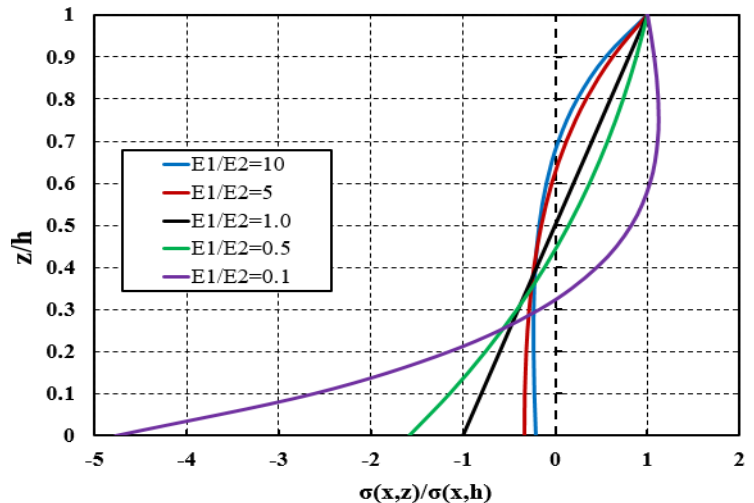
Figure 3. Normalized Axial stress σ xx distribution in simply supported E-FGM beam.